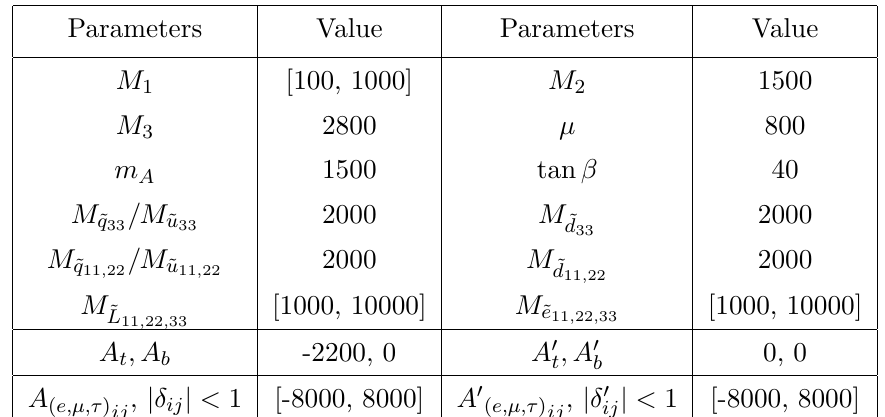
Table 3. Soft masses and trilinear parameters are listed here. All the masses and trilinear couplings are in GeV and there is no o(cid:11)-diagonal entries in the soft bilinear mass matrices.